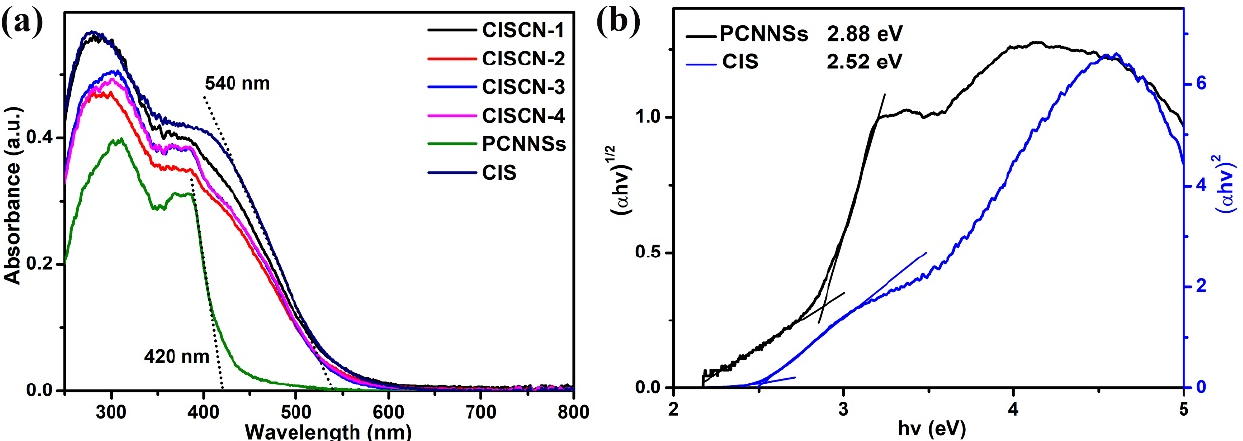
Figure 4. ( a ) UV-vis DRS of the fabricated samples and ( b ) calculation of PCNNSs and CIS bandgap energies.